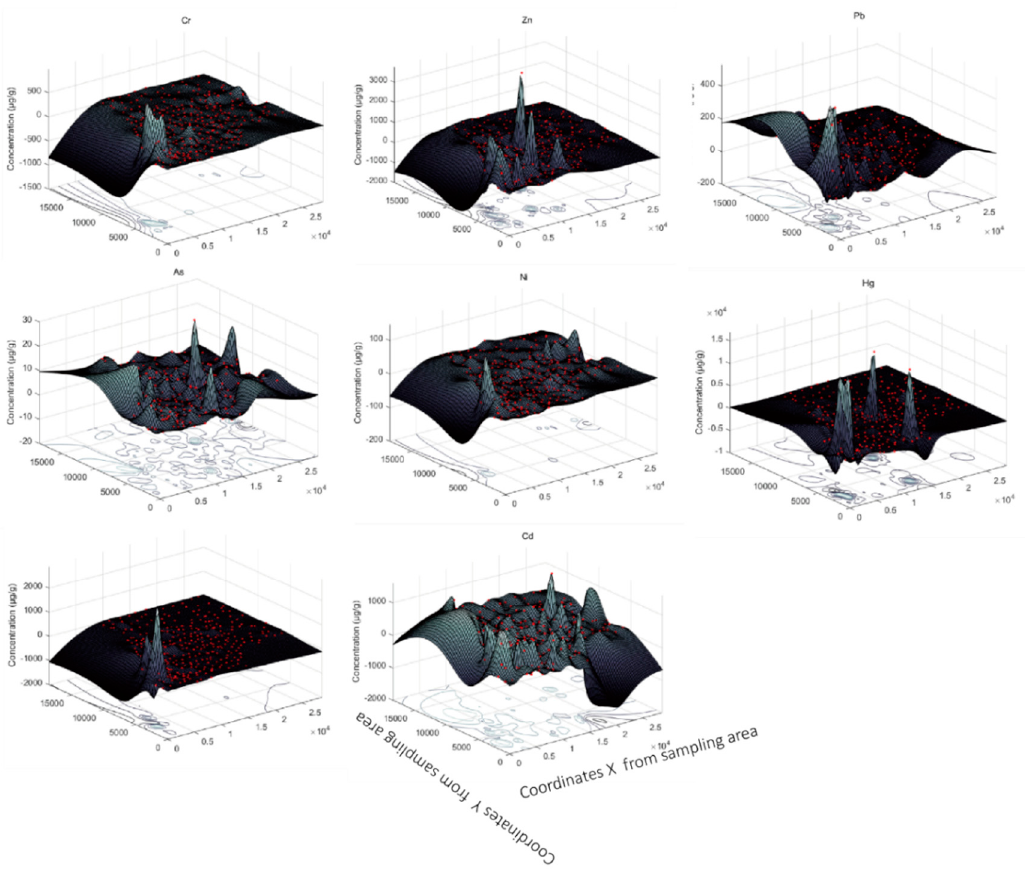
Figure 6. The spatial distribution of the metal concentrations after interpolation.